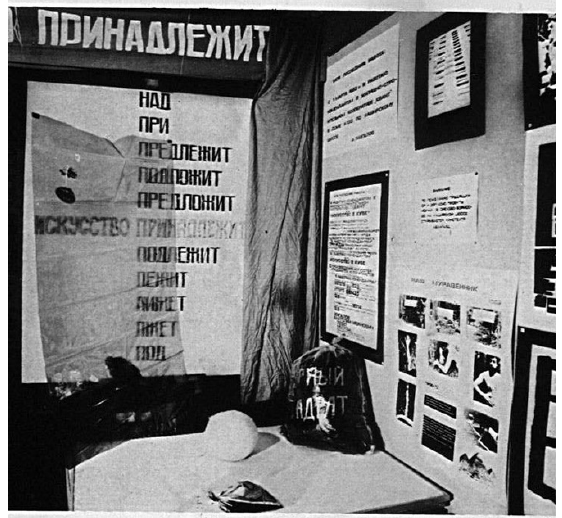
Figure 27. Abalakova and Zhigalov. Black Square . 1982. Installation view. AptArt Gallery, Moscow. Courtesy of the artists.